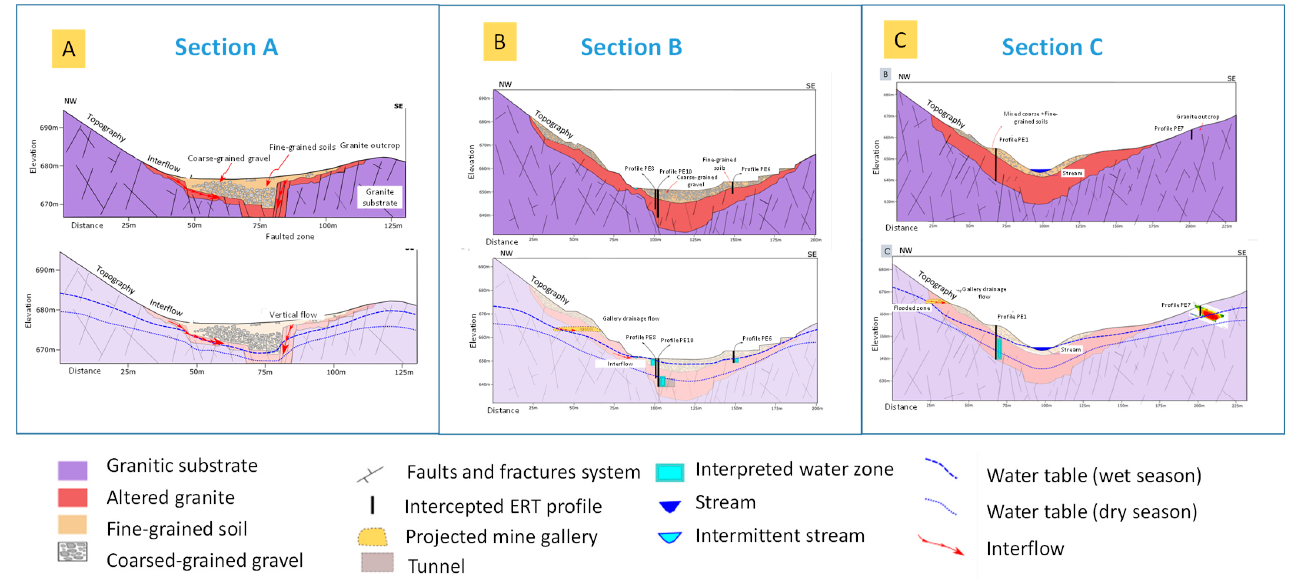
Figure 13. Geological and hydrogeological sections for wet and dry seasons respectively for ( A ) Section “A;” ( B ) Section “B;” ( C ) Section “C.” (See map location in Figure